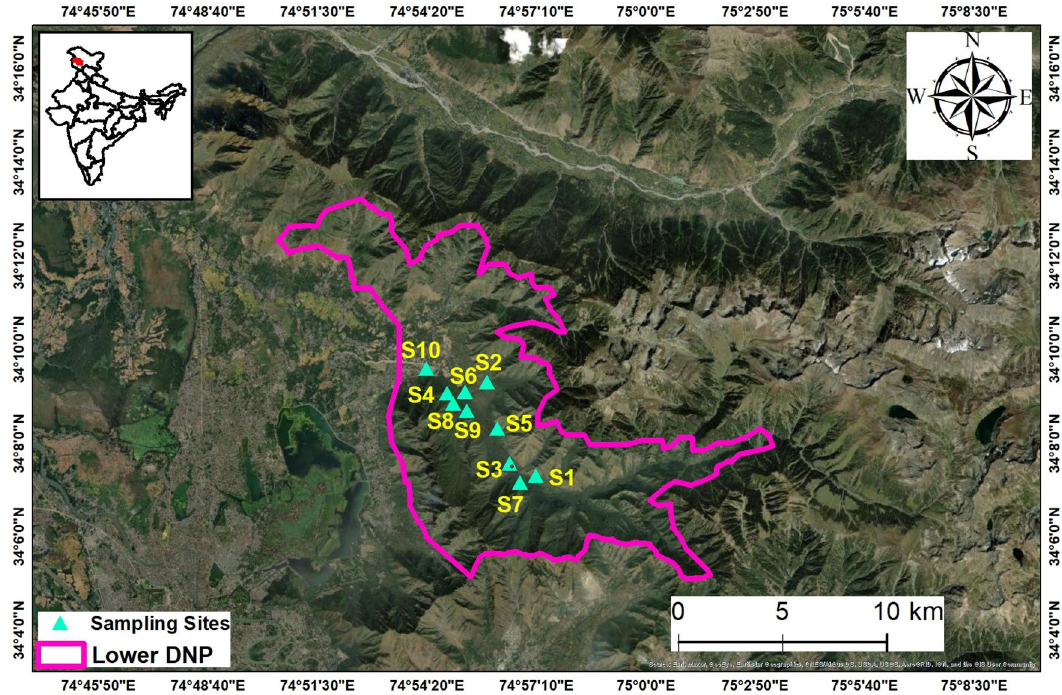
Figure 1. Map depicting different study sites in lower DNP. This figure was generated in ArcGIS version 10.4.1 (https:// www. esri. com/ en- us/ arcgis/ produ cts/ arcgis- pro/). containing a deep gorge cut by Dagwan river (and its tributaries) originating in the Marsar lake (situated at about 4200 m altitude) of alpine Upper Dachigam (also called Dagwan Valley). Soils were sampled seasonally over a period of 2 years from ten different locations covering five different dominant vegetation types in lower DNP (Table 2), with each habitat type having a low and high altitudinal site so as to ascertain the influence of vegetation and altitude on the diversity of bacteria. The detailed vegetational attributes of each site is given in the table (Table 3). Soil sampling and sampling site parameters. Soils were sampled with a sterilized soil-corer up to a depth of 15 cm in poly-ethylene (PET) bags and sterile plastic vials were used for the assessment of the soil prop-